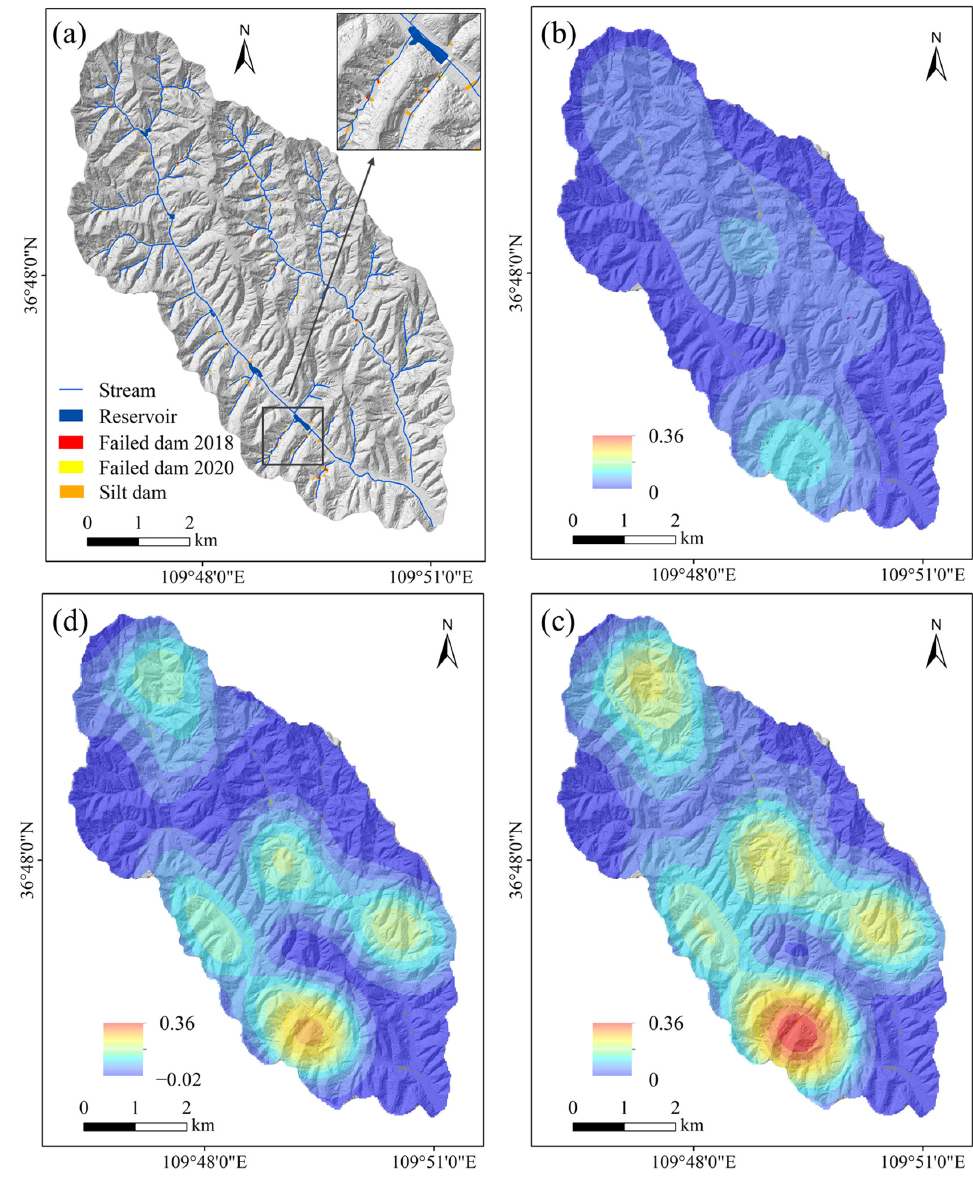
Figure 9. Spatial distribution map of the failed dam. ( a ) Spatial distribution of the failed dams in 2018 and 2020; ( b ) kernel density distribution of failed dams in 2018; ( c ) kernel density distribution of failed dams in 2020; ( d ) changes in the kernel density distribution of failed dams from 2018 to 2020.